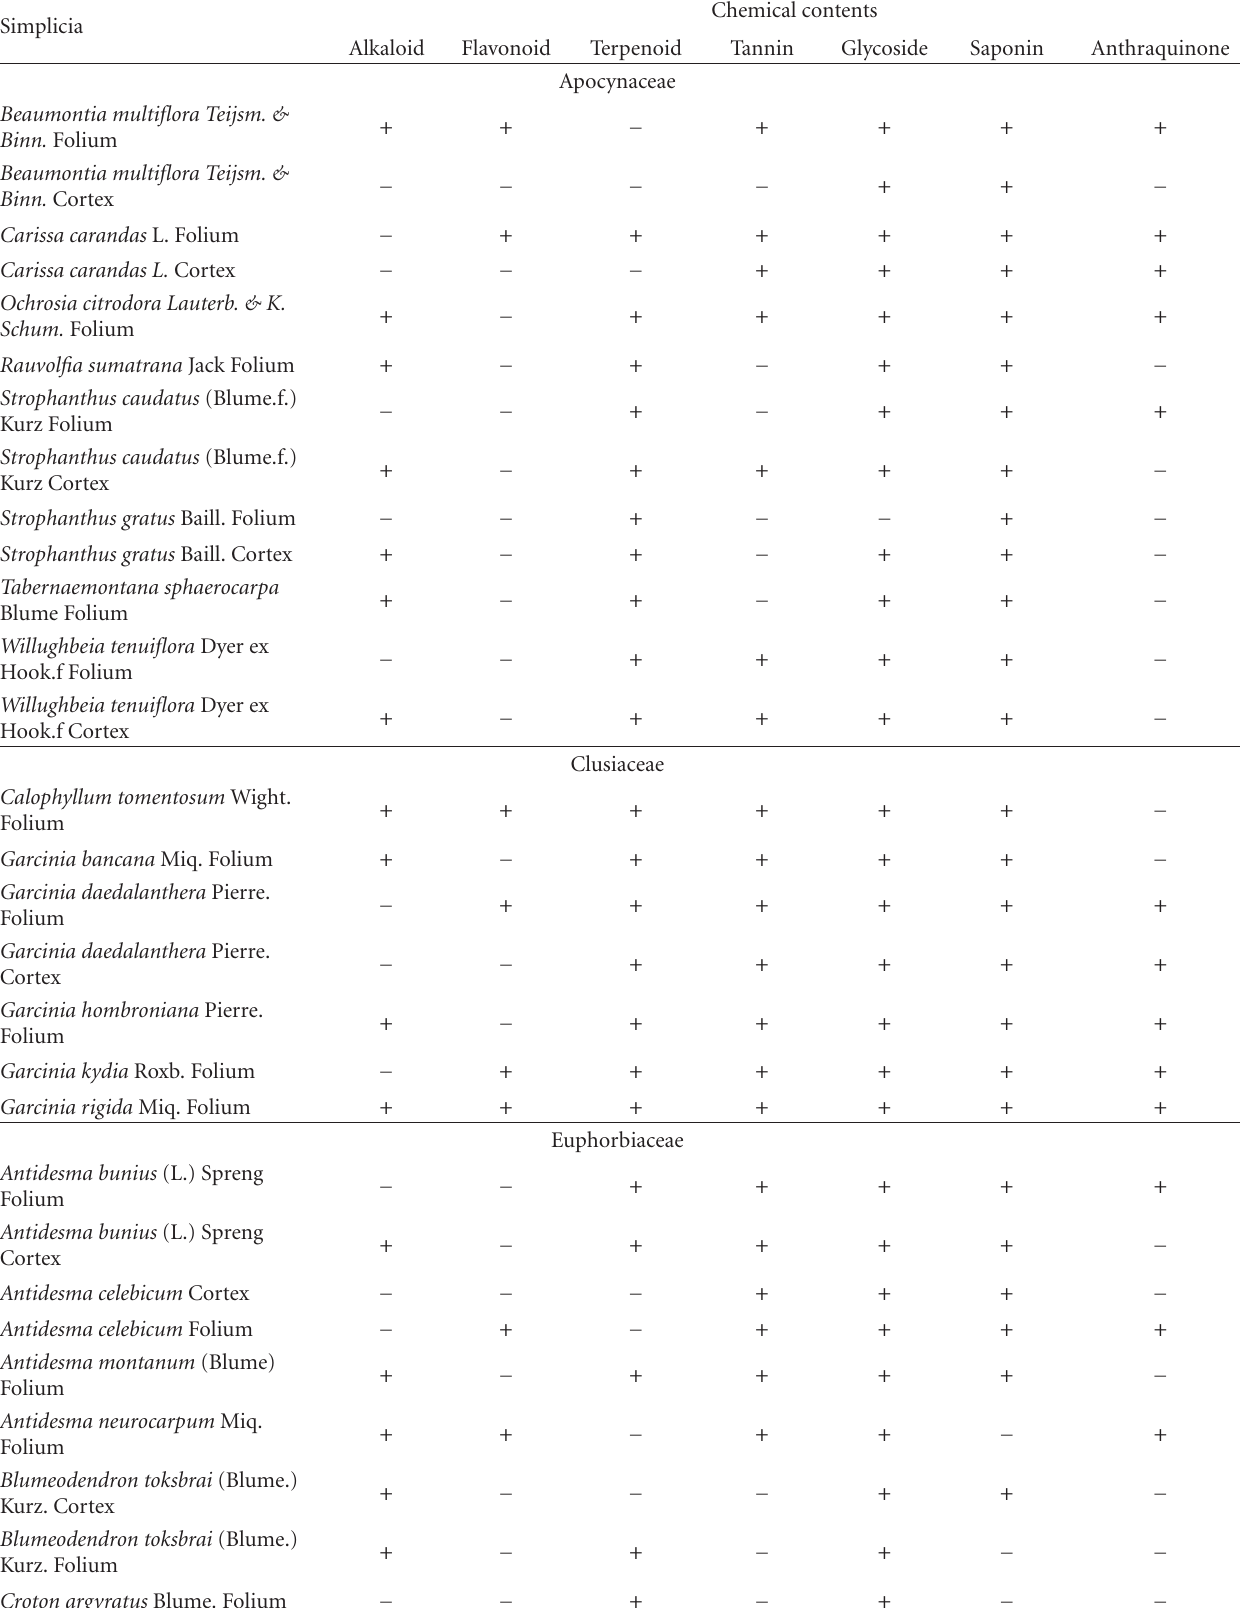
Table 1: Phytochemical screening of 80% ethanol extracts from some plants of Apocynaceae, Clusiaceae, Euphorbiaceae, and Rubiaceae.